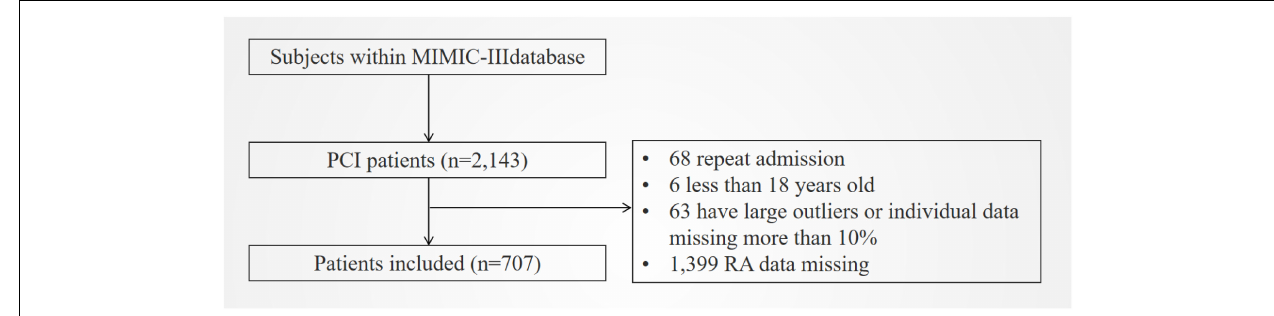
FIGURE 1 | Flowchart of included patients. MIMIC III, Multiparameter Intelligent Monitoring in Intensive Care Database III; PCI, percutaneous coronary intervention; RA, the ratio of red cell volume distribution width to